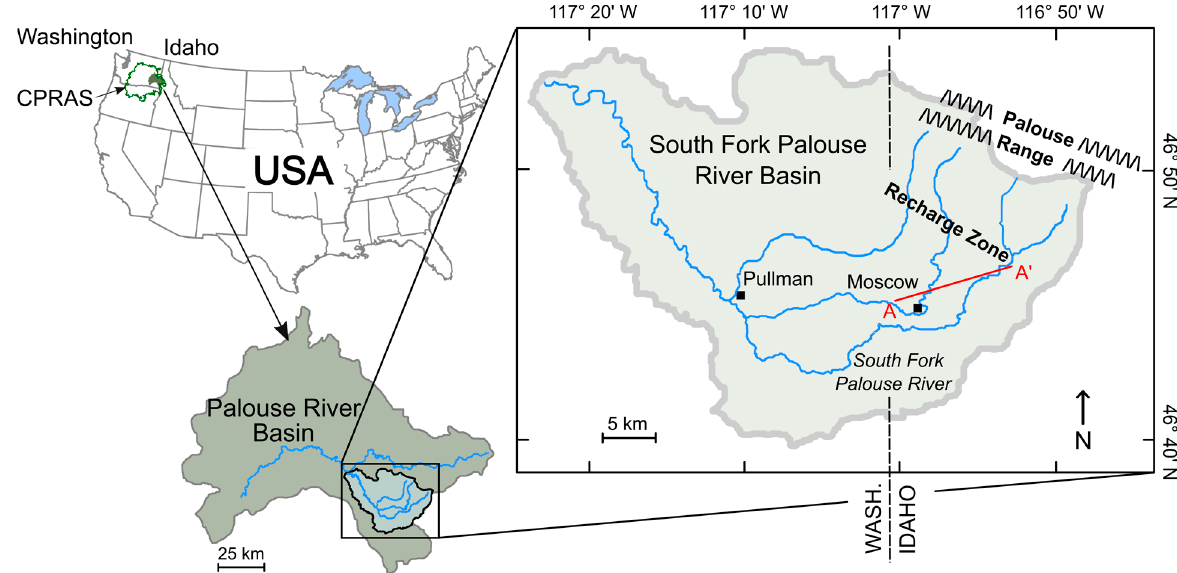
Figure 1. Location of the South Fork Palouse River Basin in the Palouse River Basin within the Columbia Plateau Regional Aquifer System (CPRAS) (modified from Behrens et al. [14]).